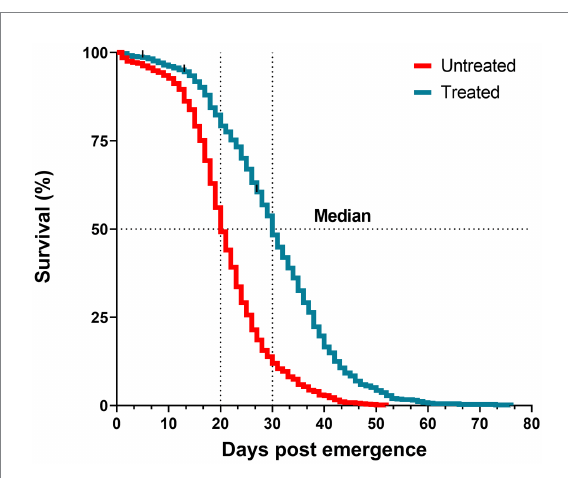
FIGURE 4 Survival curves of mosquitoes treated with antibiotics (blue line) and untreated (red line) until the last mosquito died. Log-rank test, p < 0.0001. Data are pooled from five independent experiments. Mosquitoes ( n ~ 150) per experiment and per